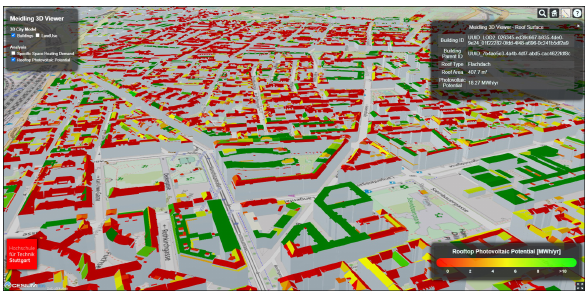
Figure 15. Meidling’s roof top PV potential visualisation